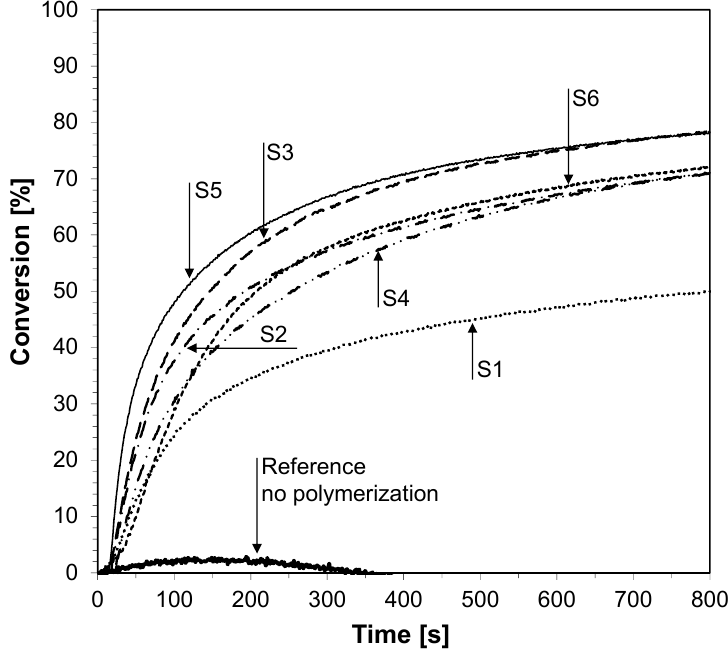
Figure 9. Polymerization profiles of CADE (epoxy function conversion vs. irradiation time) upon exposure to the LED@365 nm (190 mW/cm 2 ) under air in the presence of different photoinitiating systems based on diphenyliodonium hexafluorophosphate (HIP, 1%) and 2-amino-4,6-diphenyl-pyridine-3-carbonitrile derivatives. The irradiation starts at t = 10 s.